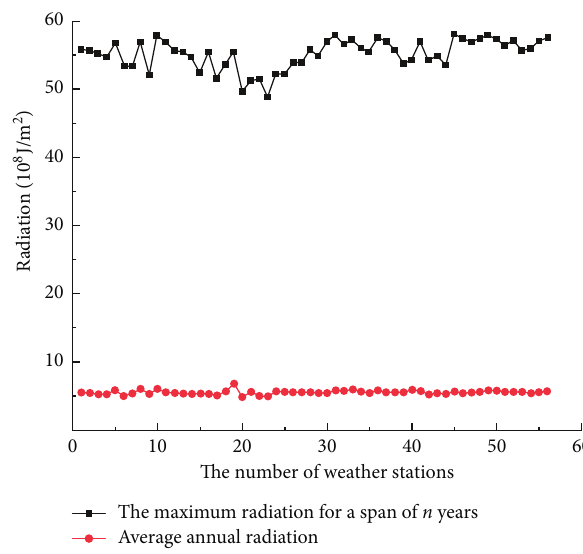
Figure 7: Main climate variables of solar radiation. Figure 5: Main climate variables of low temperature. Table 1: Explanation of variance of each principal component.